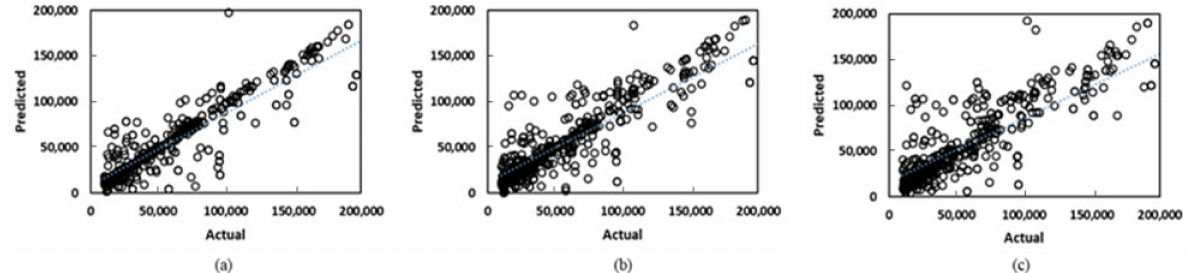
Figure 8. Coefficient of determination charts for ( a ) Stacked learner, ( b ) AdaBoost and ( c ) Random Forest when the TOF is removed as a training feature. The ordinate refer to the proxy predictions and the abscissa refer to the numerical simulation